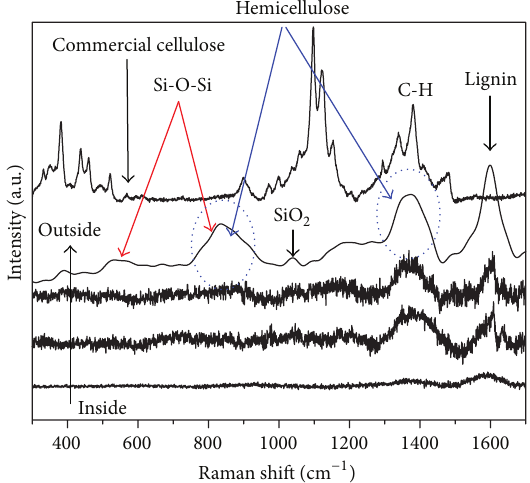
Figure 5: The Raman spectra of different radial sections of the GAKVB as well as commercial